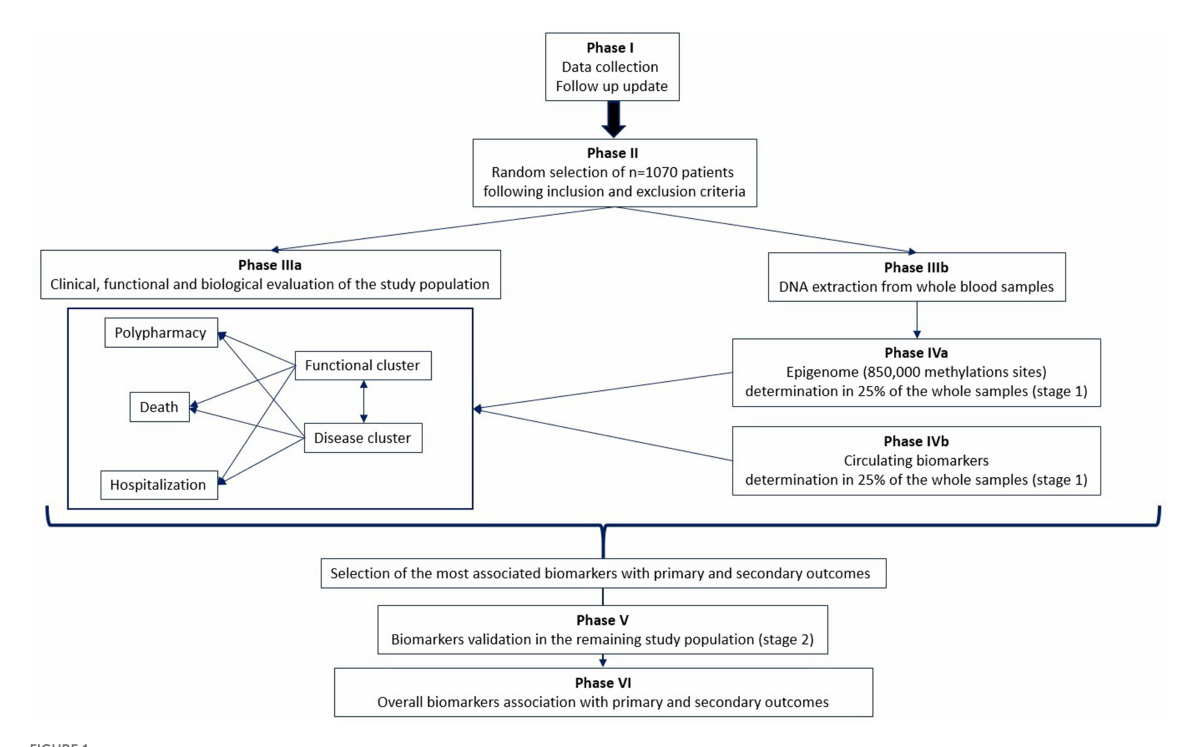
FIGURE1 Flowchart of the experimental